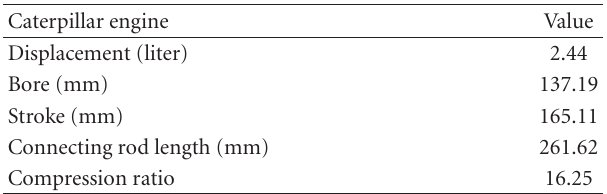
Figure 1: Parameters used in the IC engine model to determine the cylinder volume as a function of time. Table 1: A Caterpillar engine specification.